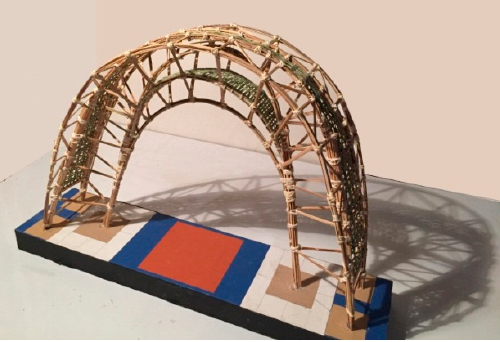
Figure 5. 1:20 Tri-arched space truss with cantilever sheds made from date palm midribs strips [8].